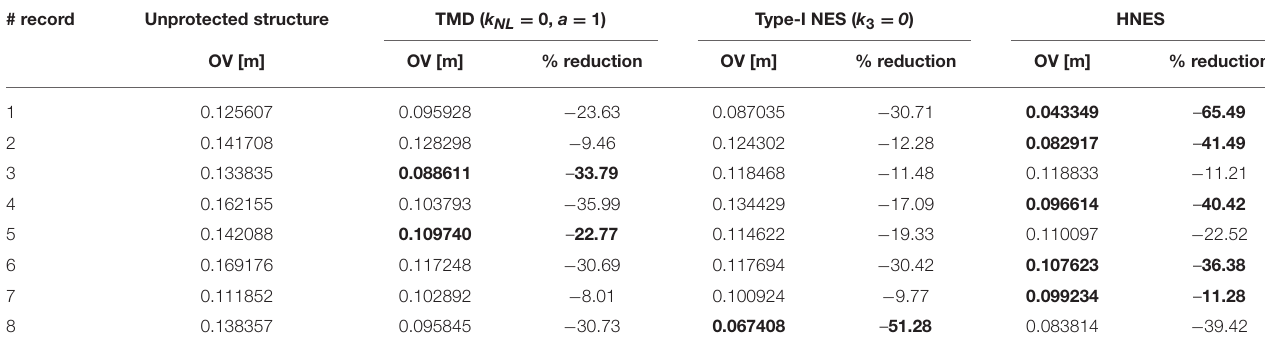
TABLE 7 | Objective values of max